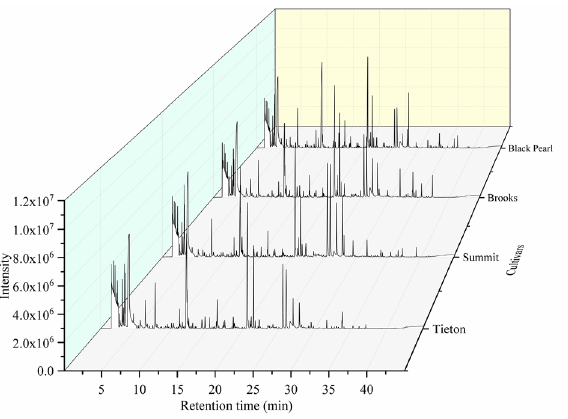
Figure 4. Total ion chromatogram of sweet cherry flower essential